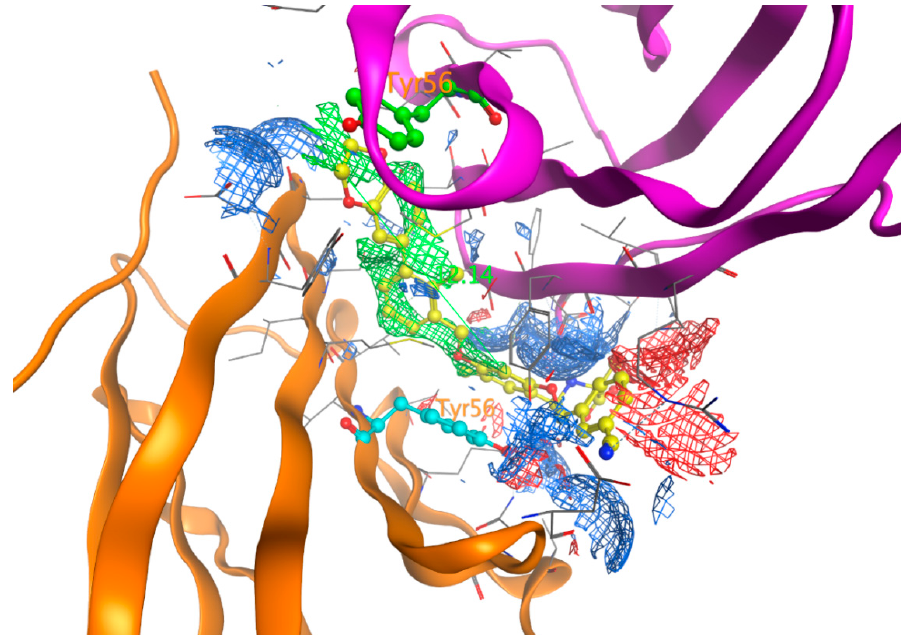
Figure 8. Interacting residues of PD-L1 with all 29 different inhibitors in the 5NIU model.